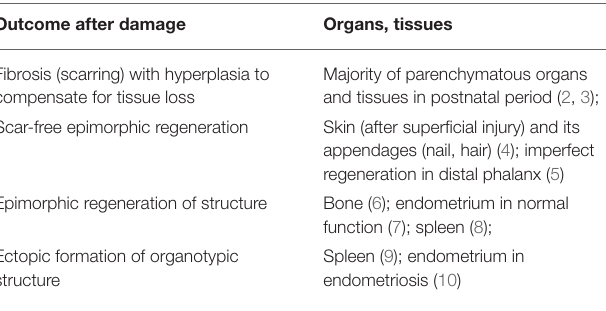
TABLE 1 | Physiological examples of regenerative capacity in humans. Outcome after